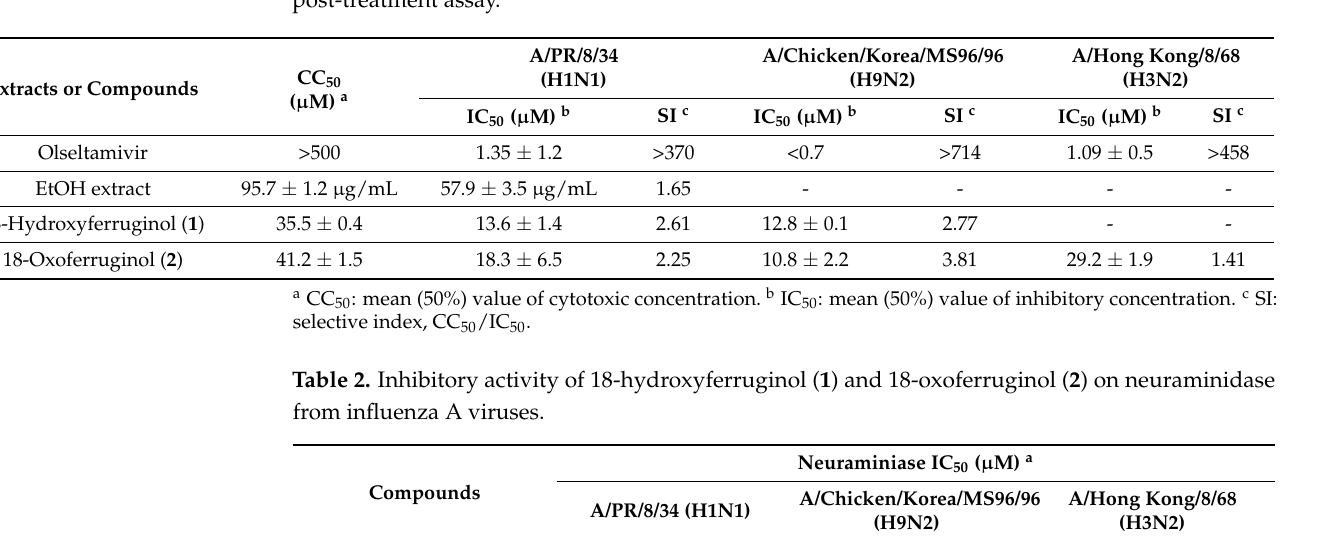
Figure 1. Effects of 18-hydroxyferruginol ( 1 ) and 18-oxoferruginol ( 2 ) on influenza viral RNA levels (M gene). ( A ) The structures of 18-hydroxyferruginol ( 1 ) and 18-oxoferruginol ( 2 ). ( B ) MDCK cells were infected with influenza viruses (0.001 MOI) for 1 h, viruses were removed, and cells were treated with 0.5% DMSO, 20 μ M 18-hydroxyferruginol ( 1 ), 20 μ M 18-oxoferruginol ( 2 ), or 10 μ M oseltamivir for 3, 6, 12, and 18 h. Total RNA was extracted after virus infection, and the level of the M gene was measured. * p < 0.05; ** p < 0.01. Table 1. Anti-influenza activity of extract and two compounds isolated from Torreya nucifera in post-treatment assay.